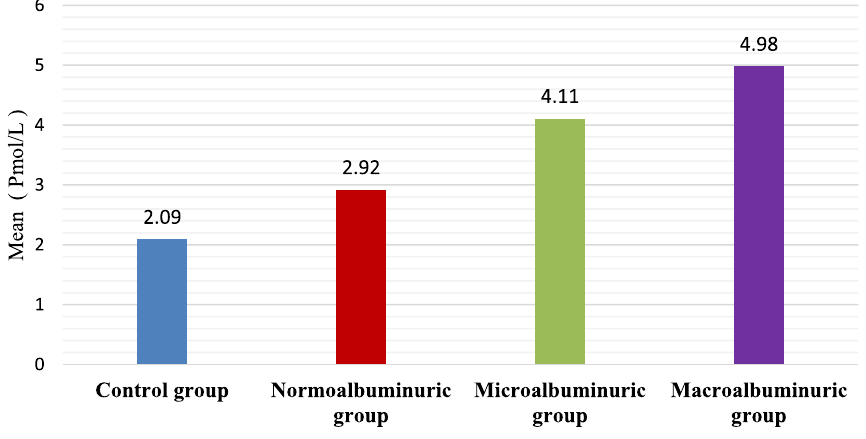
Fig. 1 Copeptin in the studied groups. The mean plasma copeptin level was statistically significantly higher in the normo group as compared to the control group, it was statistically significantly higher in micro group as compared to the control and normo groups. Also, it was statistically significantly higher in macro group as compared to the control, normo and micro groups. Abbreviations: pmol/L; Picomole per